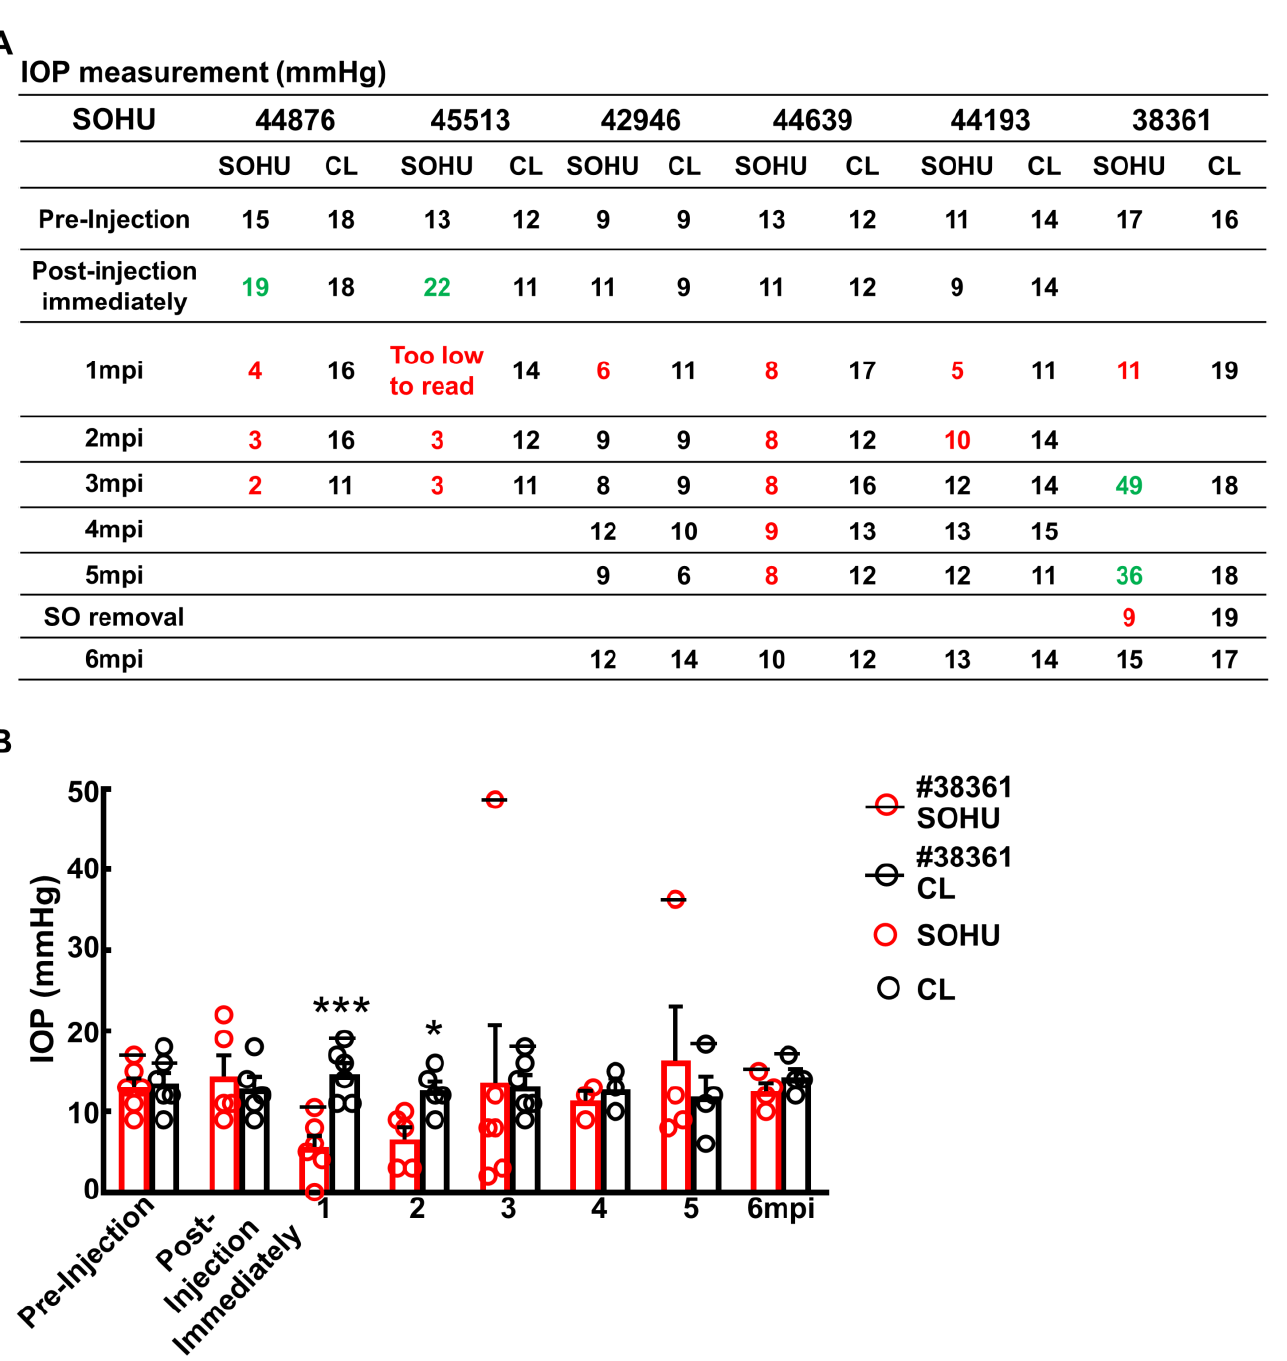
Figure 4. Dynamic IOP changes of SOHU eyes. Table ( A ) and Bar graph ( B ) presentation of longitudinal IOP measurements of experimental (SOHU) eyes and contralateral control (CL) eyes at different time points after SO injection. mpi: month post injection. Data are presented as means ± s.e.m, n = 6 (1 – 3 mpi) and n = 4 (4 – 6 mpi) of each group; *: p < 0.05, ***: p < 0.001, Student ’ s t test. Red-coded numbers are lower than normal and green-coded numbers are higher than normal IOP.